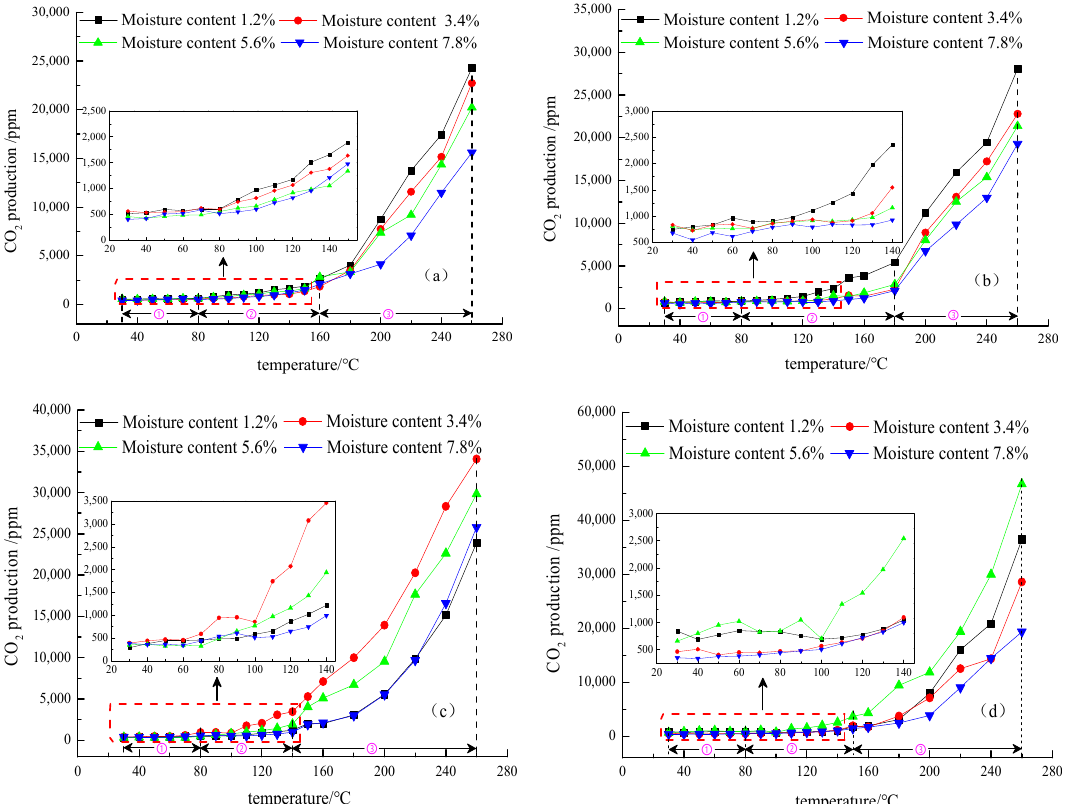
Figure 6. The curves of CO 2 production for anthracite ( a ), fat coal ( b ), long flame coal ( c ) and lignite ( d ) at four different low moisture content. ① indicates the slow oxidation stage, ② indicates the rapid oxidation stage, and ③ indicates the violent oxidation stage.